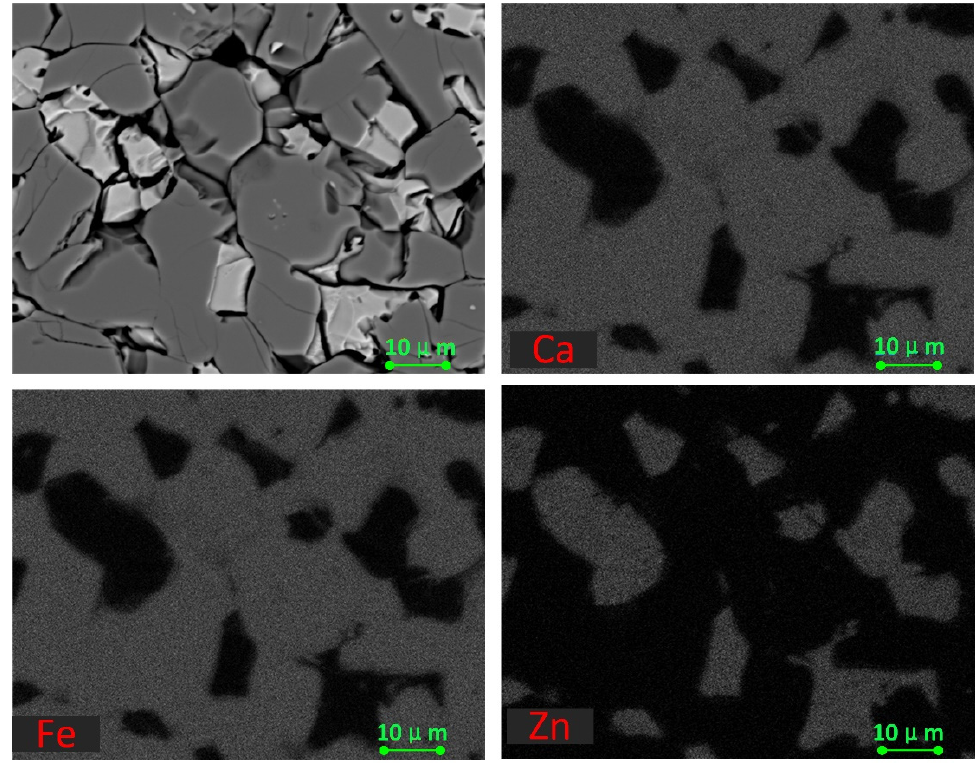
Figure 9. Main element distribution of the roasted product with the roasting time of 2 h.